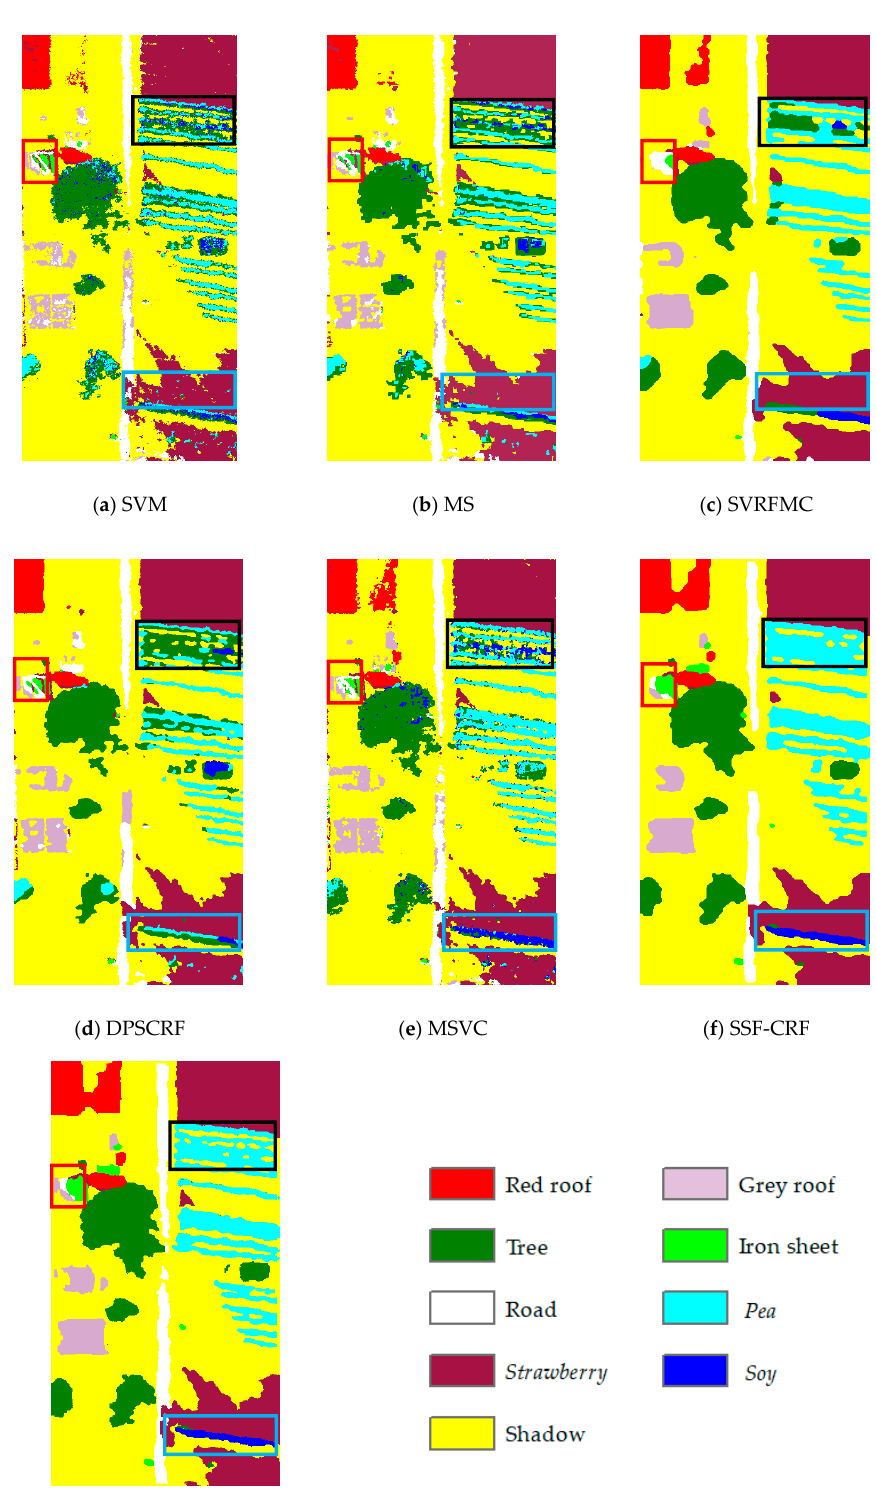
Figure 6. Hanchuan dataset classification results: ( a ) support vector machine (SVM); ( b ) mean shift segmentation (MS); ( c ) support vector conditional random field classifier with a Mahalanobis distance boundary constraint (SVRFMC); ( d ) detail-preserving smoothing classifier based on conditional random fields (DPSCRF); ( e ) Markovian support vector classifier (MSVC); ( f ) spatial-spectral fusion based on conditional random fields (SSF-CRF); ( g ) spatial-spectral-location fusion based on conditional random fields (SSLF-CRF).